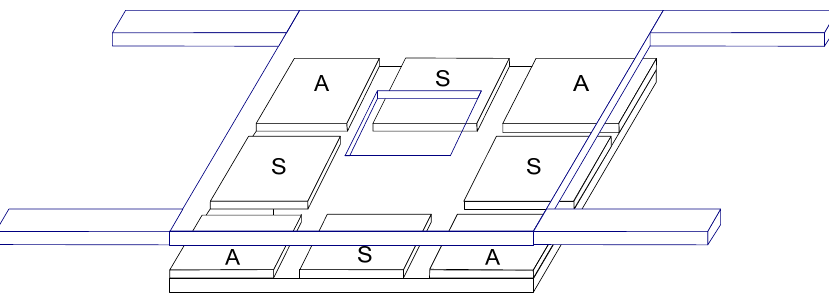
Figure 16. Schematic of square plate oscillator showing actuation and sensing